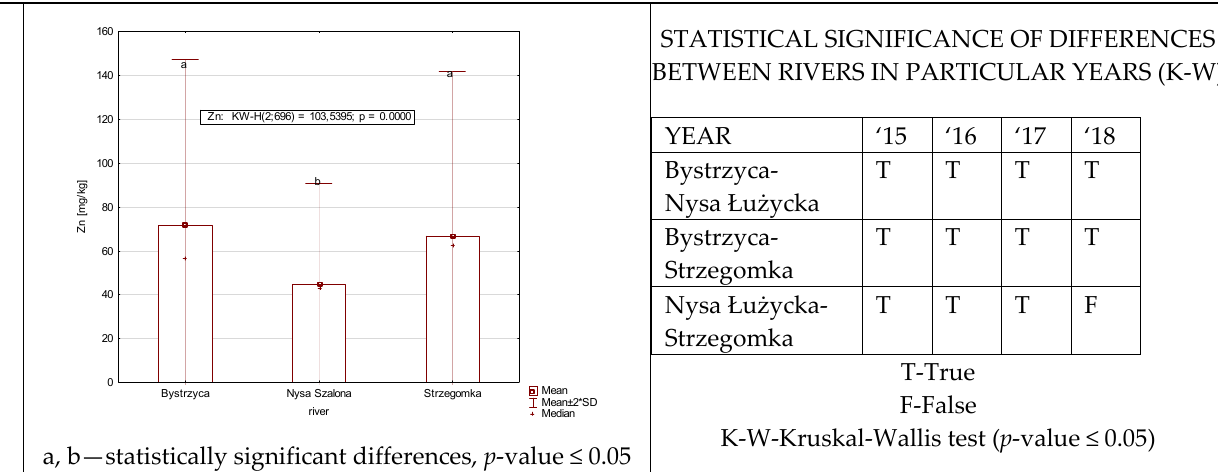
Figure 6. Zn concentration in plants from rivers across 29 sites depending on river (graph to the ( left )) and by year 2015–2018 in the table to the ( right ). Statistically significant differences are marked in the graph with letters a, b and in the table these differences are shown by year between rivers—T—differences were present, F—no statistical difference ( p -value ≤ 0.05).